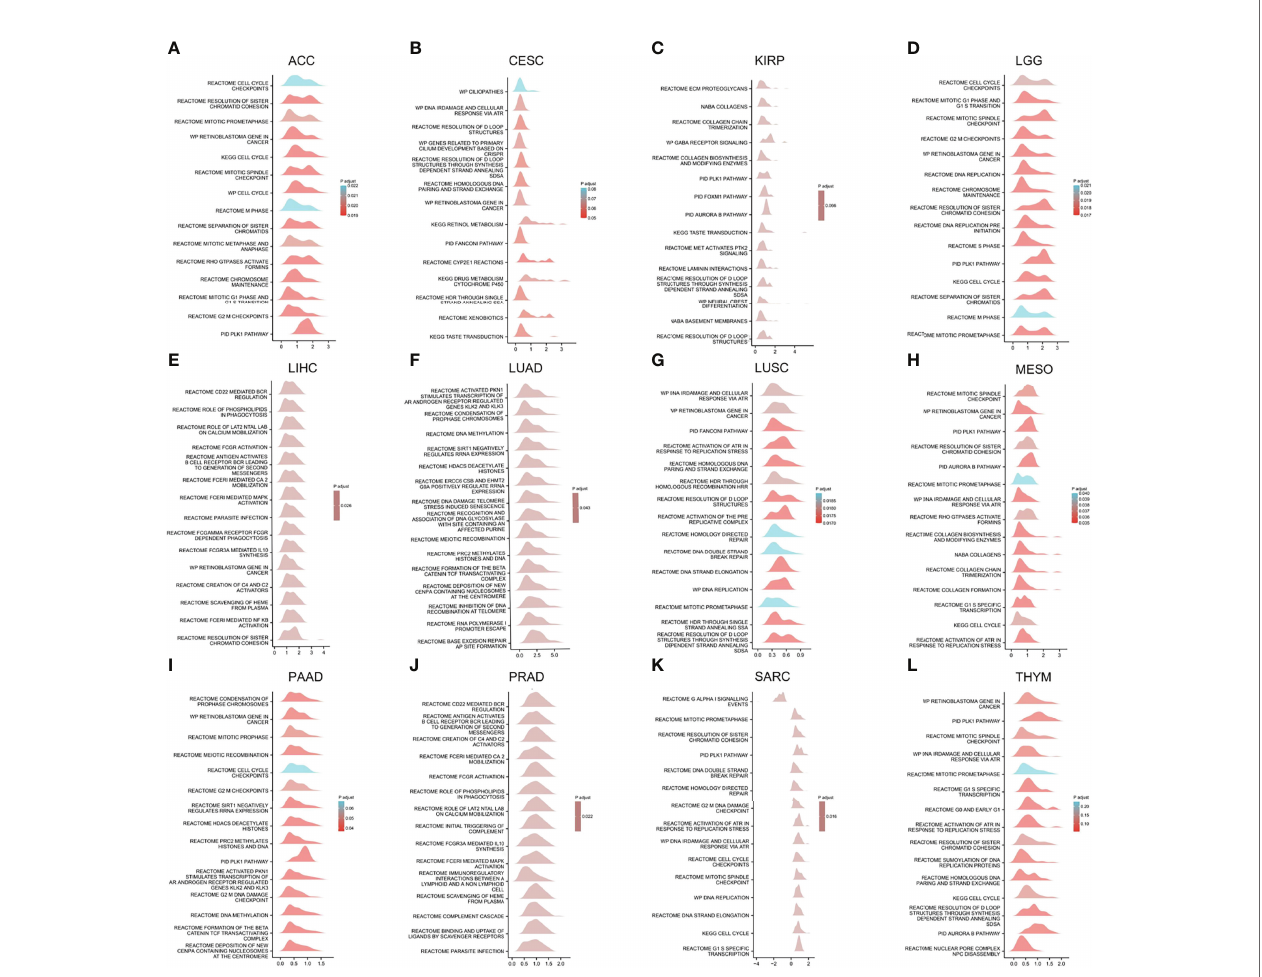
FIGURE 10 | GSEA functional enrichment analysis of HELLS expression in 12 cancers. The top 15 GSEA functional enrichment pathways of HELLS in (A) ACC, (B) CESC, (C) KIRP, (D) LGG, (E) LIHC, (F) LUAD, (G) LUSC, (H) MESO, (I) PAAD, (J) PRAD, (K) SARC, (L) THYM. The Y-axis represents one gene set and the X-axis is the distribution of logFC corresponding to the core molecules in each gene